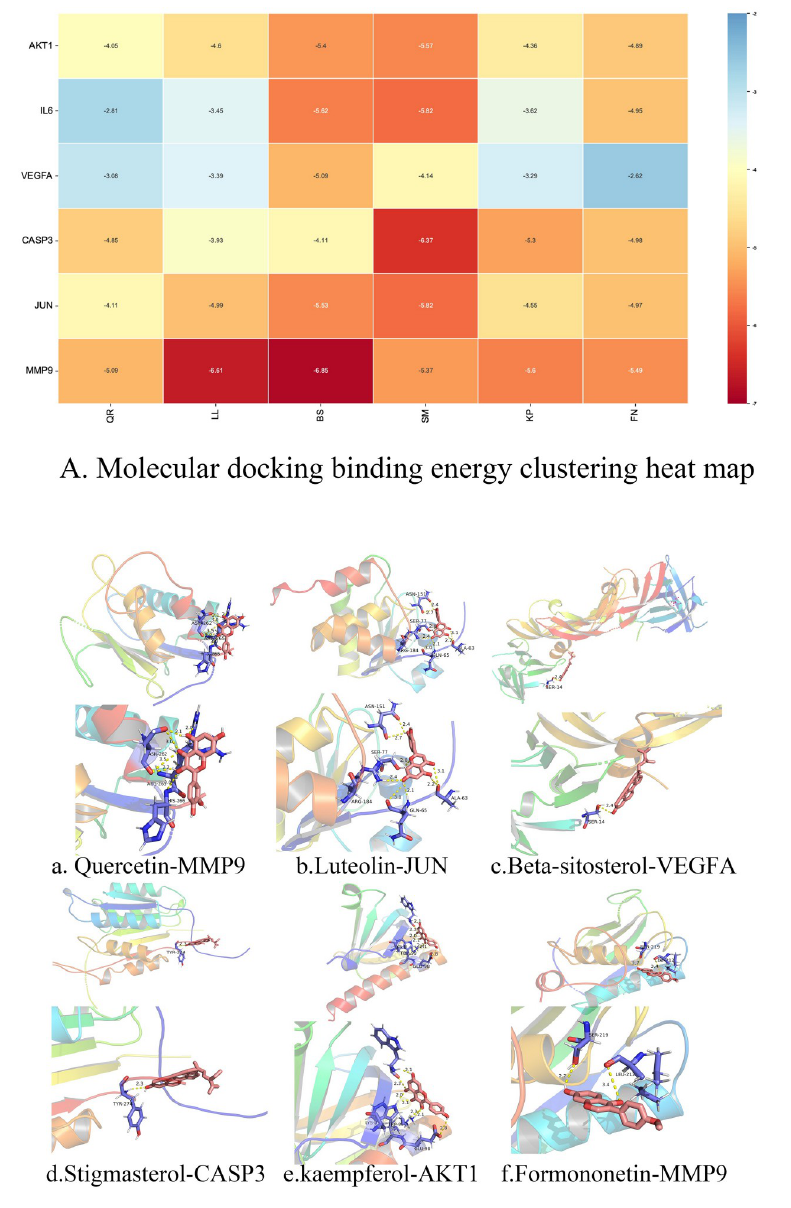
Fig 5. Molecular docking diagram. Note: A. Heat map of molecular docking binding energy. The smaller the value of molecular docking binding energy is, the docking is stable, and the color changes with the value of binding energy. Quercetin(QR), luteolin(LL), beta-sitosterol (BS), Stigmasterol (SM), kaempferol (KP), formononetin (FN). B. Docking effect drawing of core components and core targets. In this study, Through TCMSP, 43 active ingredients for LTG corresponding to 192 target genes were identified, and quercetin belongs to flavonols, luteolin, kaempferol and formono- netin belongs to flavonoids, β sitosterol and stigmasterol belong to plant sterols. These natural compounds are found in a wide variety of plants and have powerful antioxidant and anti-